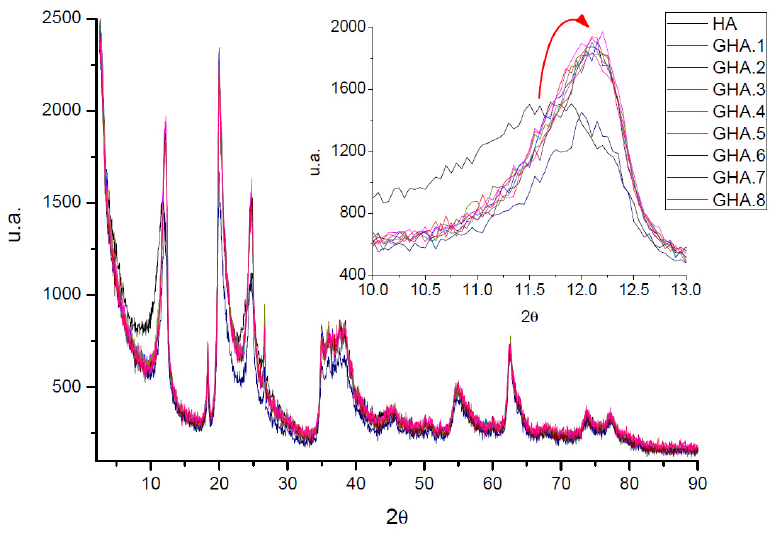
Figure 12. XRD patterns for the halloysite (HA), and the chlorophyll hybrid pigments [GHA.1_8].